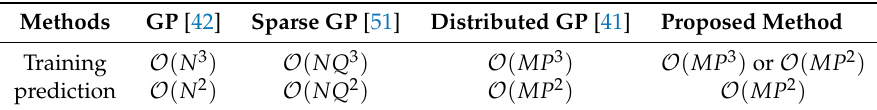
Table 4. Comparison of computation cost.